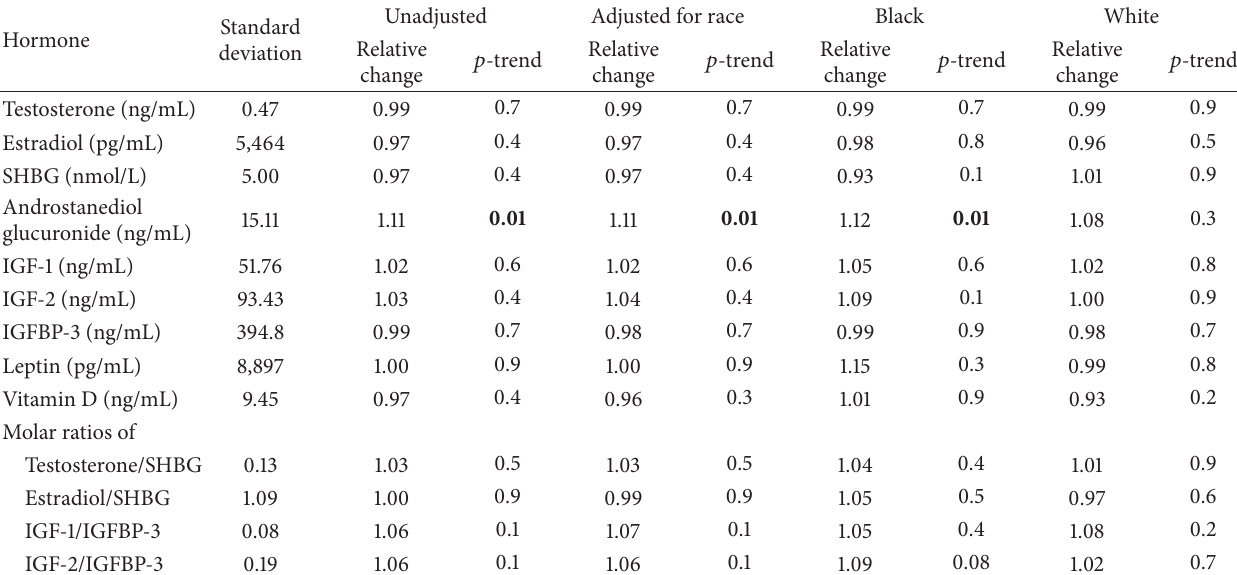
Estradiol/SHBG 1.09